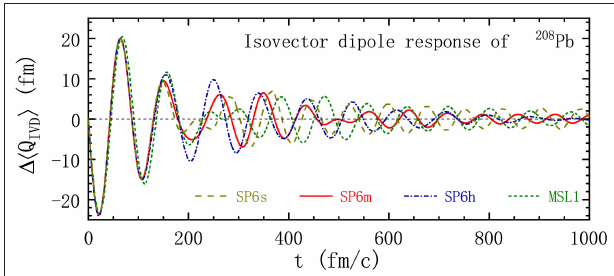
FIGURE 5 | Same as Figure 4 but for the isovector dipole mode with λ 25 MeV / c . Reproduced from reference [61] with permission from the = American Physical